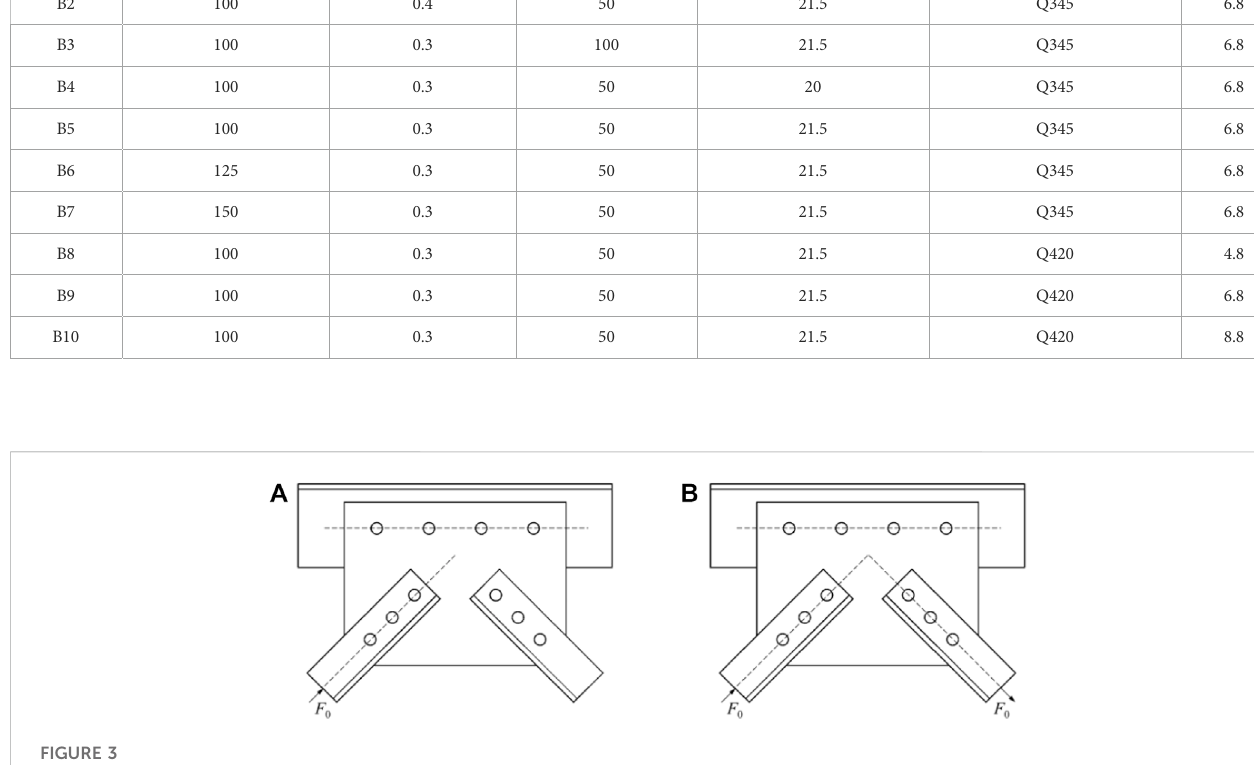
Loading mode of Group (A) and Group (B)